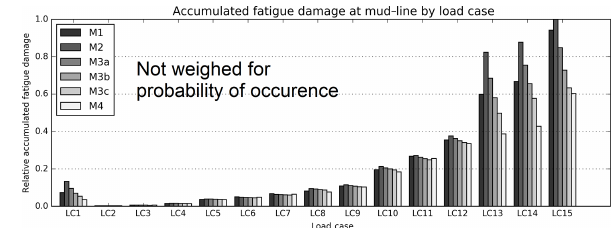
Figure 21. Accumulated fatigue damage at mud-line arranged by load case without probability of occurrence.